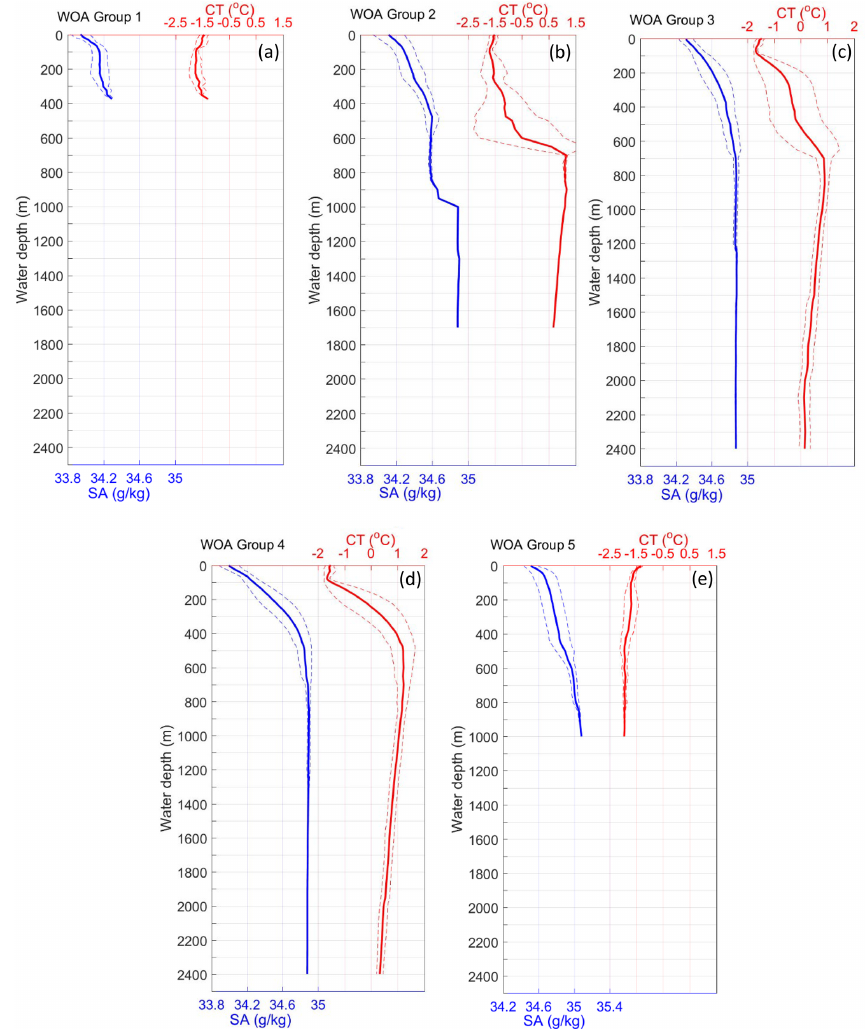
Figure 5. Mean (solid lines) WOA salinity (in blue) and temperature (in red) profiles for five groups (from a to e ) shown in Fig. 3e; ± 1 SD at each depth is shown with dashed